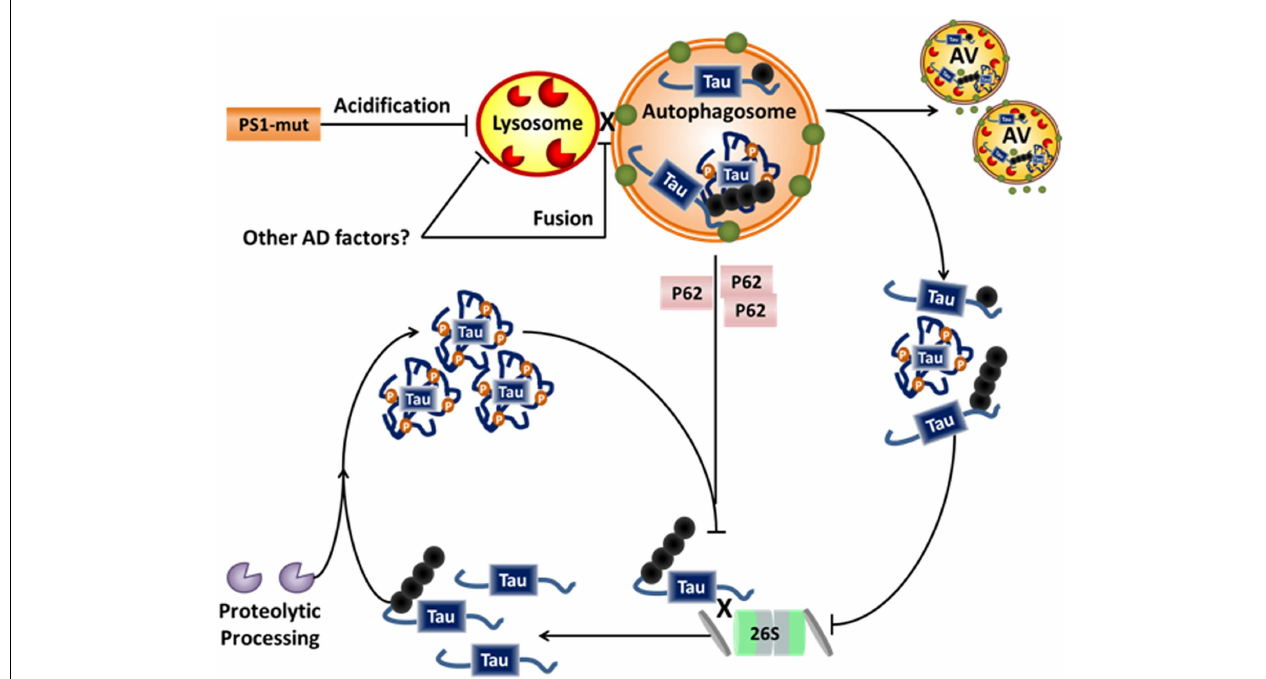
FIGURE 3 |Alzheimer disease-related disruption of tau degradation . Impairment of protein degradation is a known component of both familial and sporadic AD. Familial AD-related mutations of PS1 are linked to impairment of lysosomal acidification and/or fusion to the autophagosome, while sporadic factors leading to similar impairments have not yet been elucidated. Impairment of the lysosome/autophagosome leads to accumulation of dysfunctional autophagic vacuoles (AVs), cytosolic p62, and aggregates of tau. Dysfunction of autophagy further inhibits the proteasome, possibly via accumulation of p62, which can be a